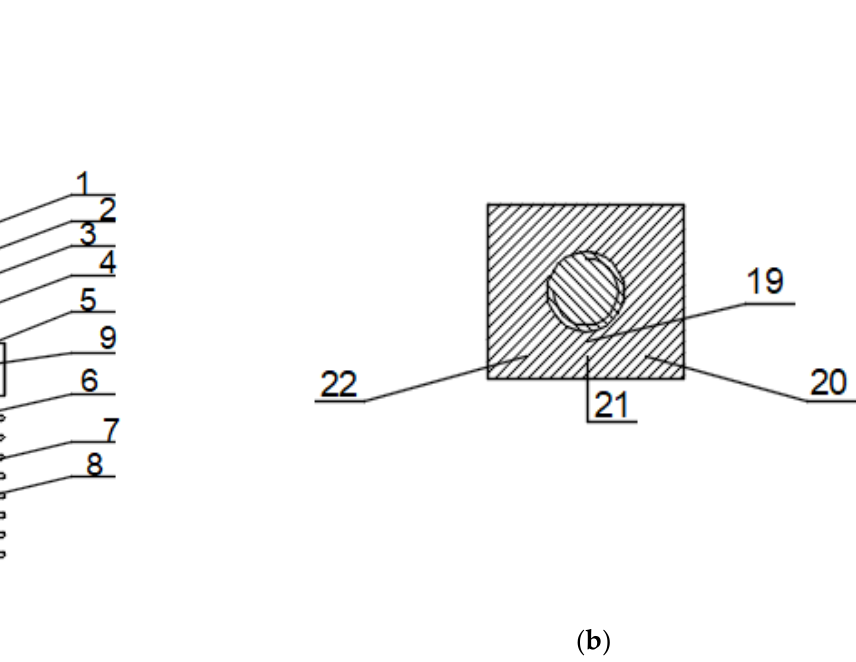
Figure 2. The locations of the markers on the diode case and on the heat sink surface: ( a ) side view; ( b ) top view of the heat sink.